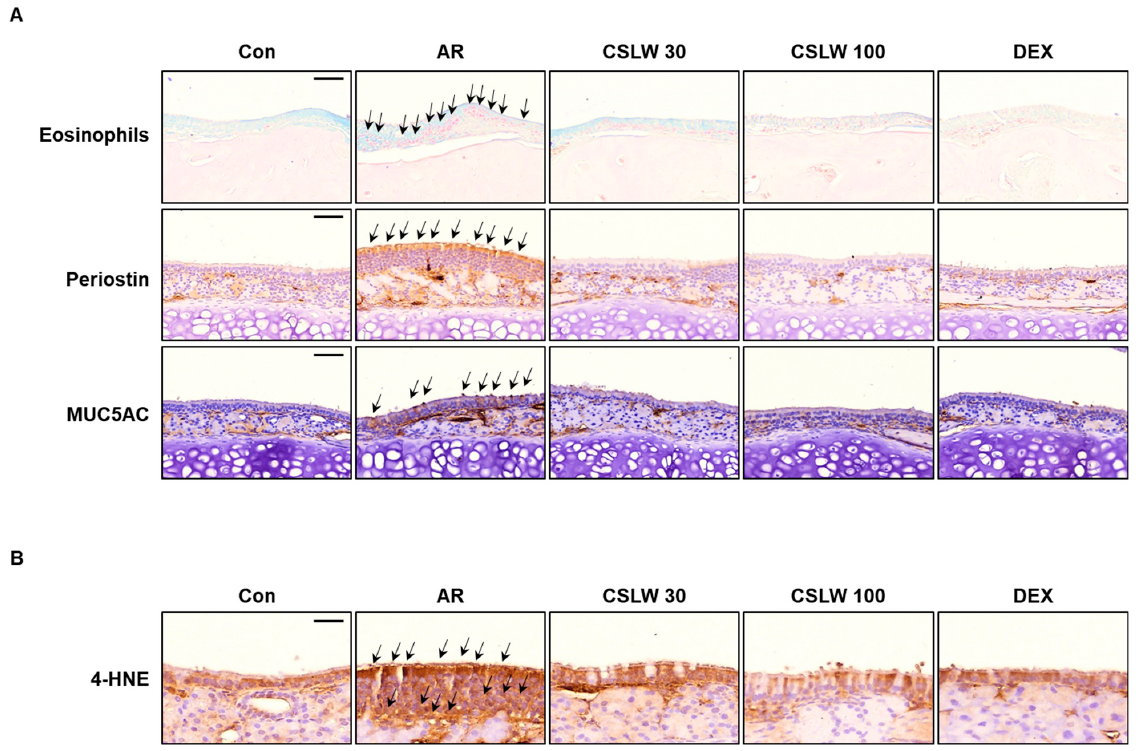
Figure 5. Effect of CSLW on histopathological changes in the nasal tissues. ( A ) Eosinophils stain via Giemsa staining. Infiltration of the eosinophils (stained bright red); the black arrow indicates the eosinophil (scale bar = 50 μ m). Immunohistochemical staining for periostin ( A , middle), MUC5AC ( A , lower), and 4-HNE ( B ). Periostin (arrows indicate allergic inflammation, scale bar = 50 μ m), MUC5AC (arrows indicate mucus production, scale bar = 50 μ m), and 4-HNE (arrows indicate oxidative damage, scale bar = 20 μ m) are stained brown. AR, allergic rhinitis; OVA, ovalbumin; CSLW, Caesalpinia sappan Linn. heartwood water extract; DEX, dexamethasone.